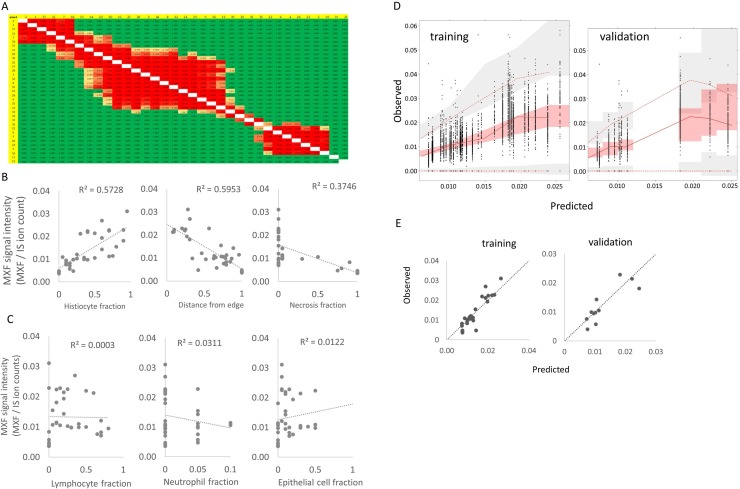
Identification of the drivers of moxifloxacin distribution in cellular lesion compartments.(A) Statistical analysis of MXF relative abundance per area: average pixel intensities in each ROI were compared using a one-way analysis of variance (ANOVA) comparing the mean MXF pixel intensity in each of the 35 areas, and a Tukey post-hoc test for multiple comparisons. The number of pixels per ROI ranged from 48 and 429. Green cells indicate comparisons with p≤0.05. (B) Plots of the Spearman rank correlations between MXF abundance and the fraction of histiocytes (including macrophages and foamy macrophages), relative distance of ROI to granuloma edge and fraction of necrosis. The method used to measure the relative distance of each sub-area to granuloma edge, a surrogate of vascular efficiency, is described in Figure 3—figure supplement 3. (C) Plots of Spearman rank correlations between MXF abundance and fraction of lymphocytes, neutrophils, and epithelial cells. (D) Visual Predictive checks of the final model developed on the training dataset (left), and internal validation showing predicted MXF abundance using ROI-specific measurements of histiocytes, distance ratio and % necrotic cells in the final model equation. MXFabundance=θ1×eθ2×(Histiocytes%-0.35)×eθ3×(DistanceRatio-0.65)×(1+θNecrosis) where θ1-3andθnecrosis are model estimated constants and are reported in supplementary file 1 The lines and shaded areas in D are as follows: continuous red line: observed data median; dotted red line: 5th and 95th percentile of the observed data; light red shaded area: predicted median with uncertainty; light grey shaded area: predicted percentiles of the data with uncertainty. (E) Visual Predictive Checks (VPC) similar to the plots described in (D) but showing only the median signal intensity for each ROI. Dotted line: line of identity.